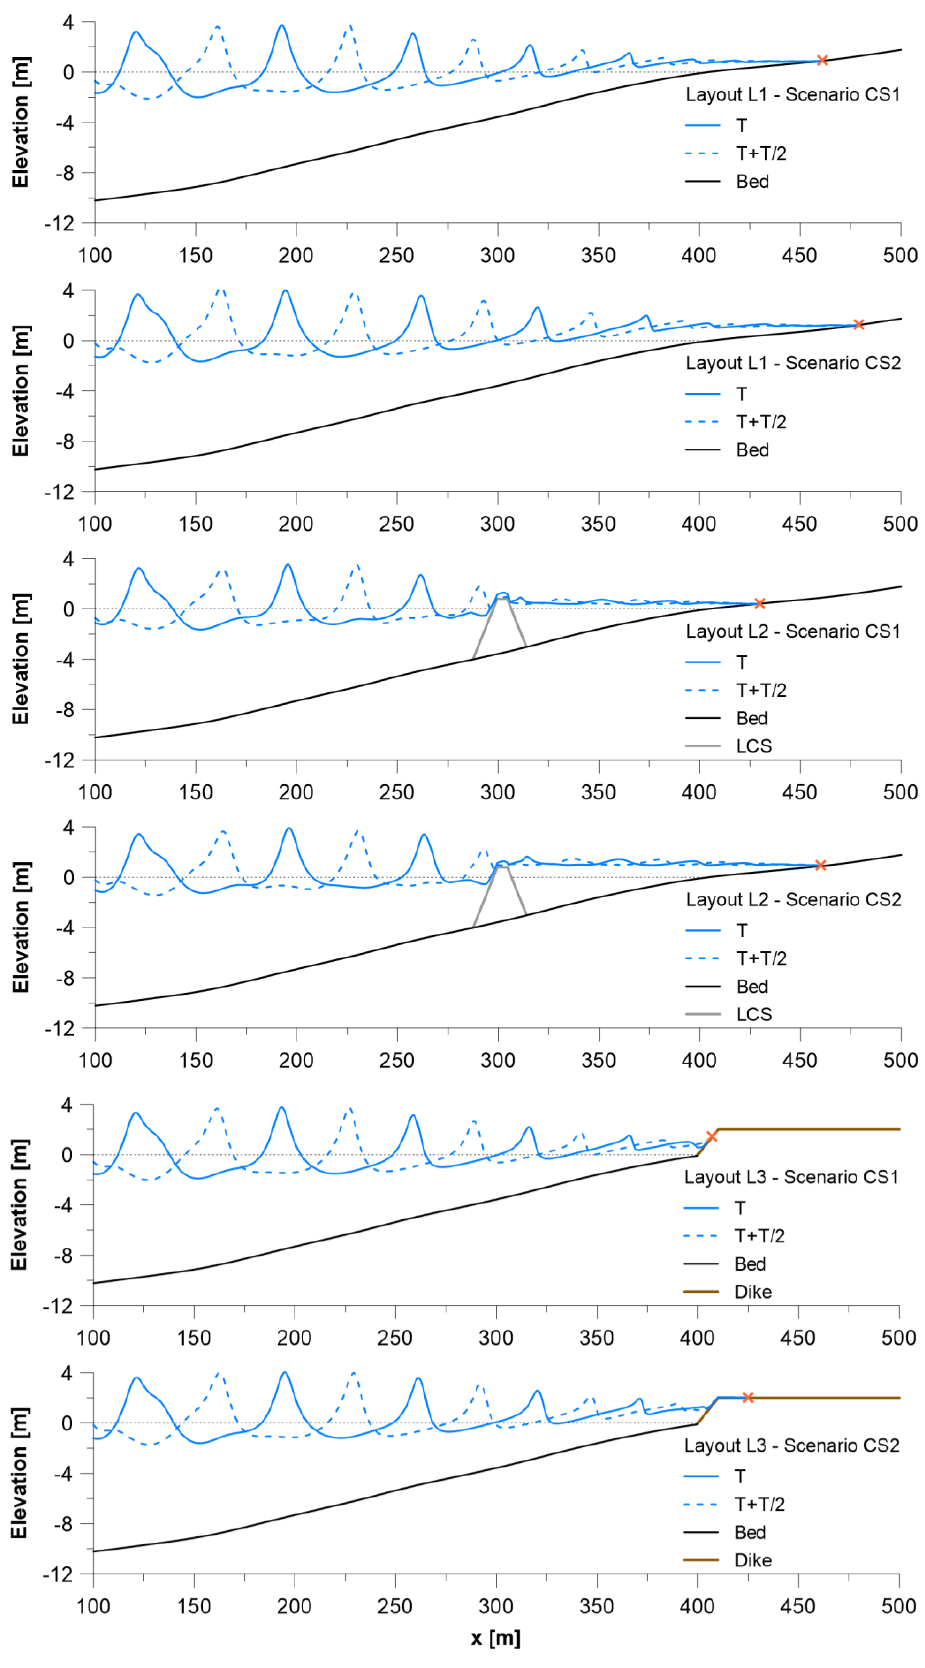
Figure 9. Model results for the combinations of layouts L1 , L2 , L3 and scenarios CS1 and CS2 . Coloured “x” symbols denote the landward limit of the flooding extent .